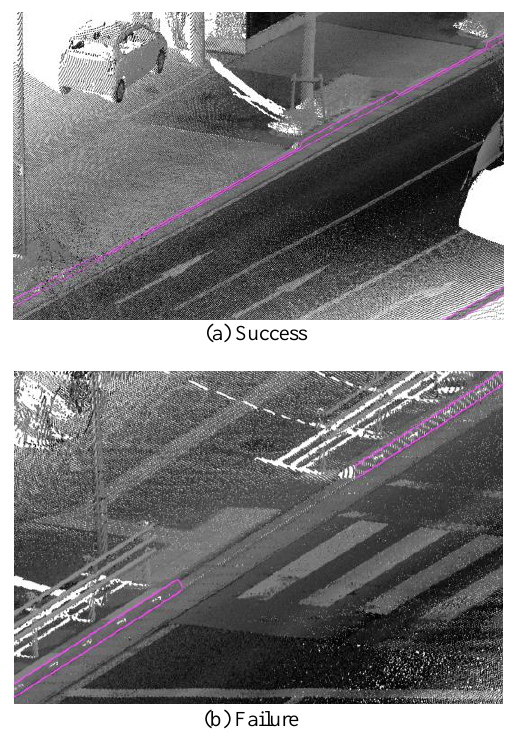
Figure 12. Extraction results of curbs with small